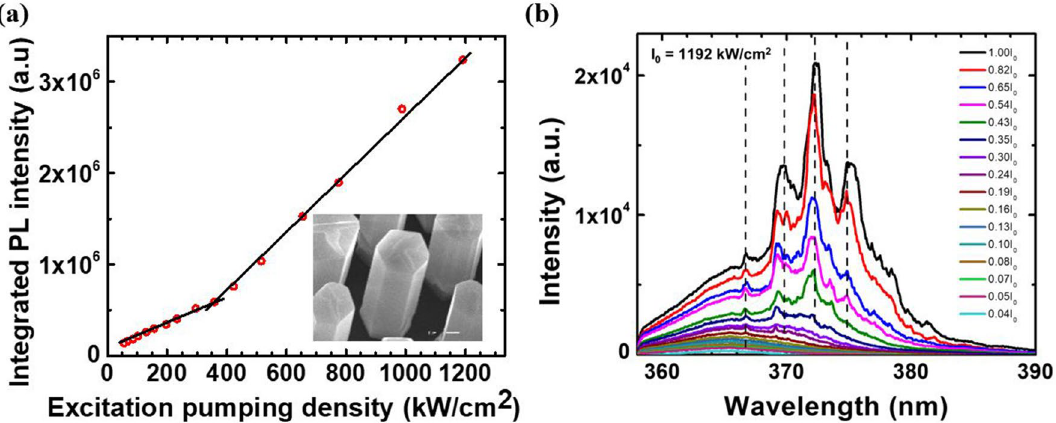
Figure 3. ( a ) The plot of integrated PL intensity as a function of excitation density at 350 KW/cm 2 . ( b ) Representative power-dependent PL spectra of GaN